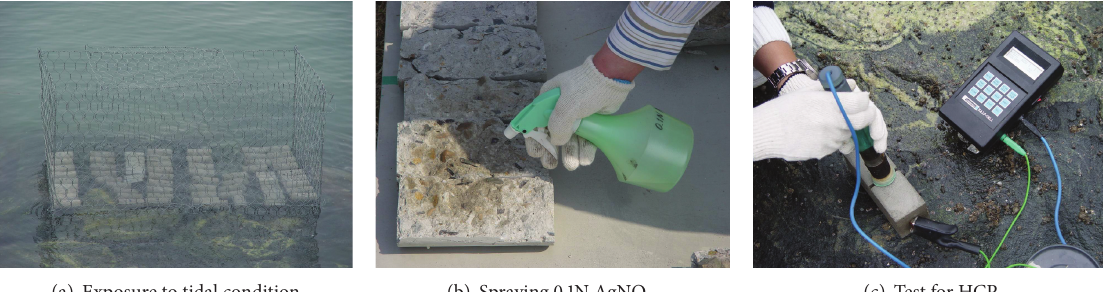
Figure 3: Photos for long-term chloride exposure